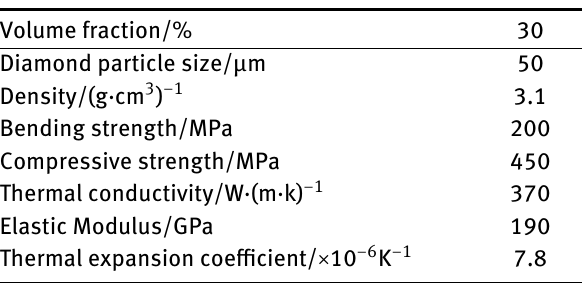
Figure 2: Principle of ELID plane